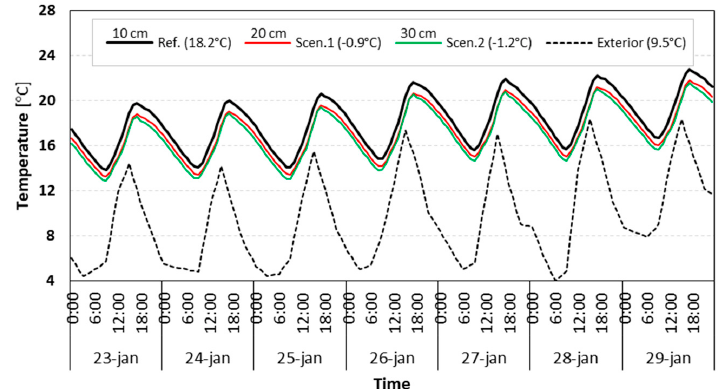
Figure 13. Influence of different air cavity thicknesses.